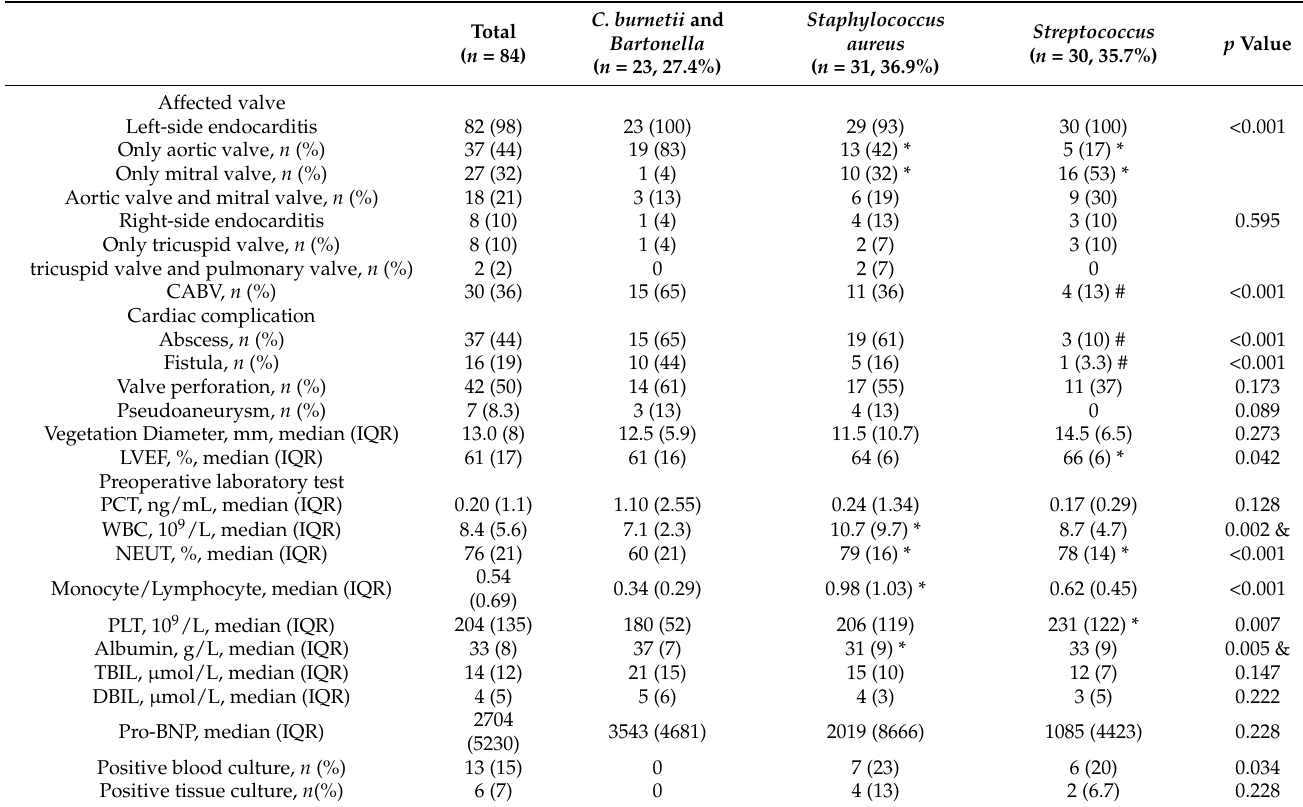
Table 2. Echocardiographic and laboratory findings in 84 patients with infective